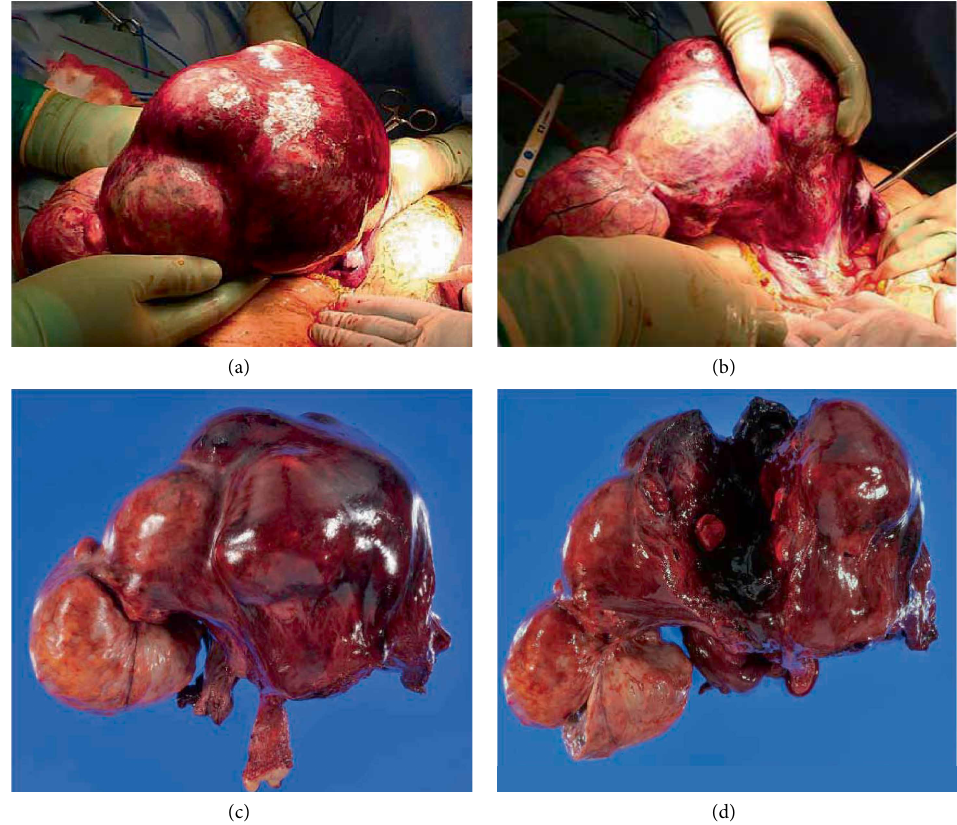
Figure 3: Operative findings of the twisted myomatous uterus. (a) The myomatous uterus was rotated 360 degrees clockwise on the long axis at the level of the isthmus. The uterine surface was discolored, appearing dark red because of the congestion. (b) After releasing the torsion, the uterine color turned red and the lower uterine segment was observed. (c) The resected myomatous uterus and bilateral adnexa. The surface of the uterus was dark red and the cervix was significantly elongated. (d) A cross-section of the uterus revealed the accumulation of clotting blood inside the